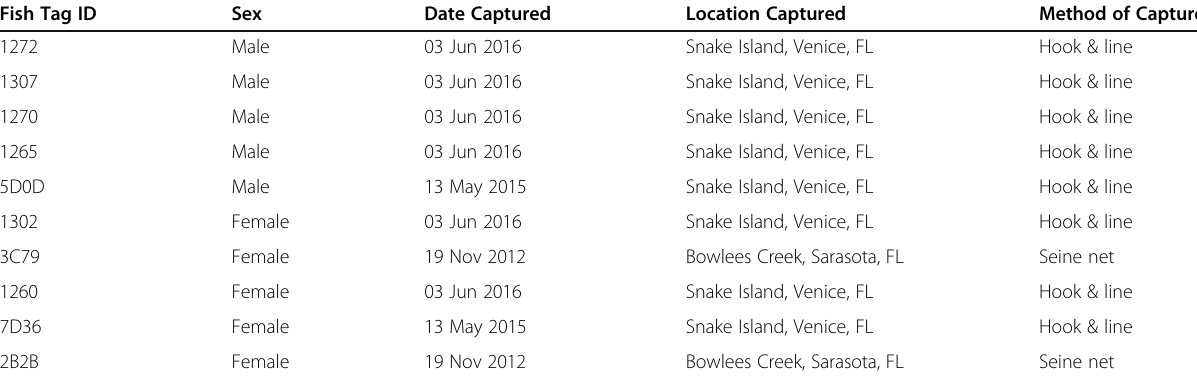
Table 1 Capture dates and locations of captive broodstock sampled in this study Fish Tag